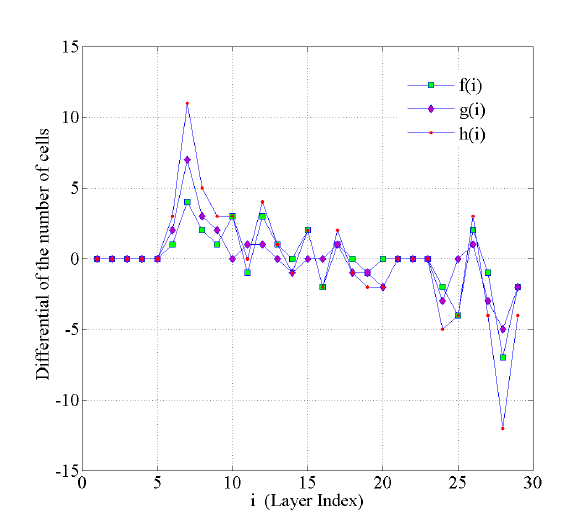
Figure 4: Fist degree differential of the number of cells in each layer.